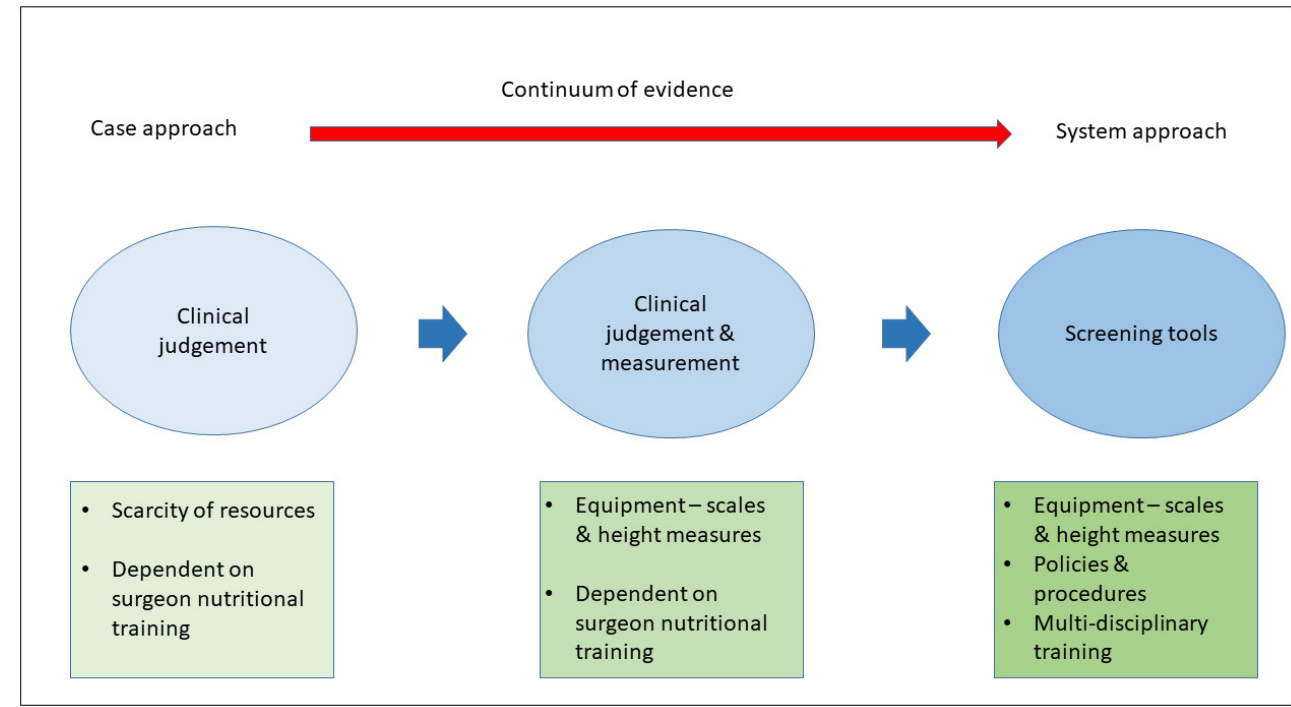
Figure 1. Nutritional assessment in